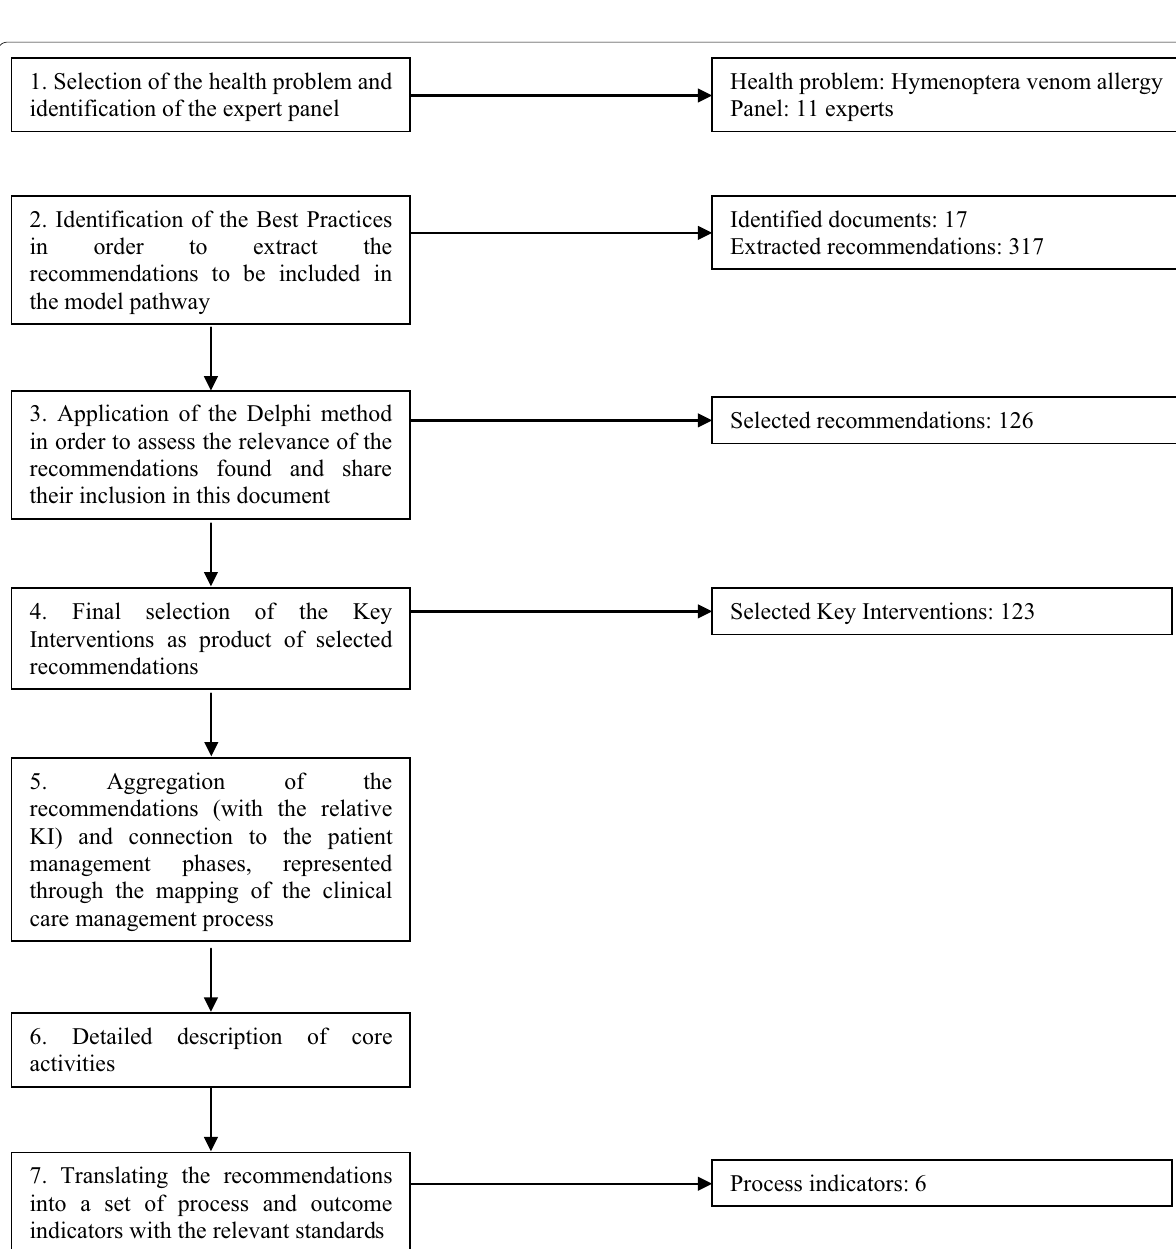
Fig. 3 Methodology for the development of the clinical